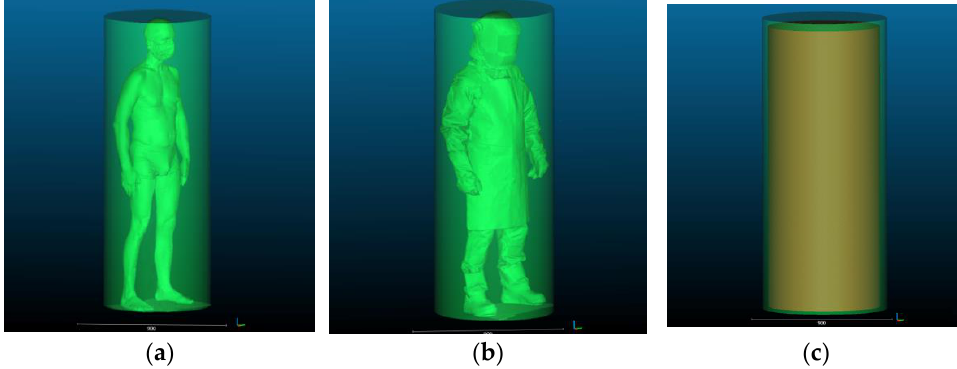
Figure 6. Human silhouette: ( a ) in underwear circumscribed by a cylinder; ( b ) in welding PPE – circumscribed by a cylinder; and ( c ) illustration of dimensional allowances for the welding PPE kit used in the study showing differences in the size of the human body in underwear and in PPE.